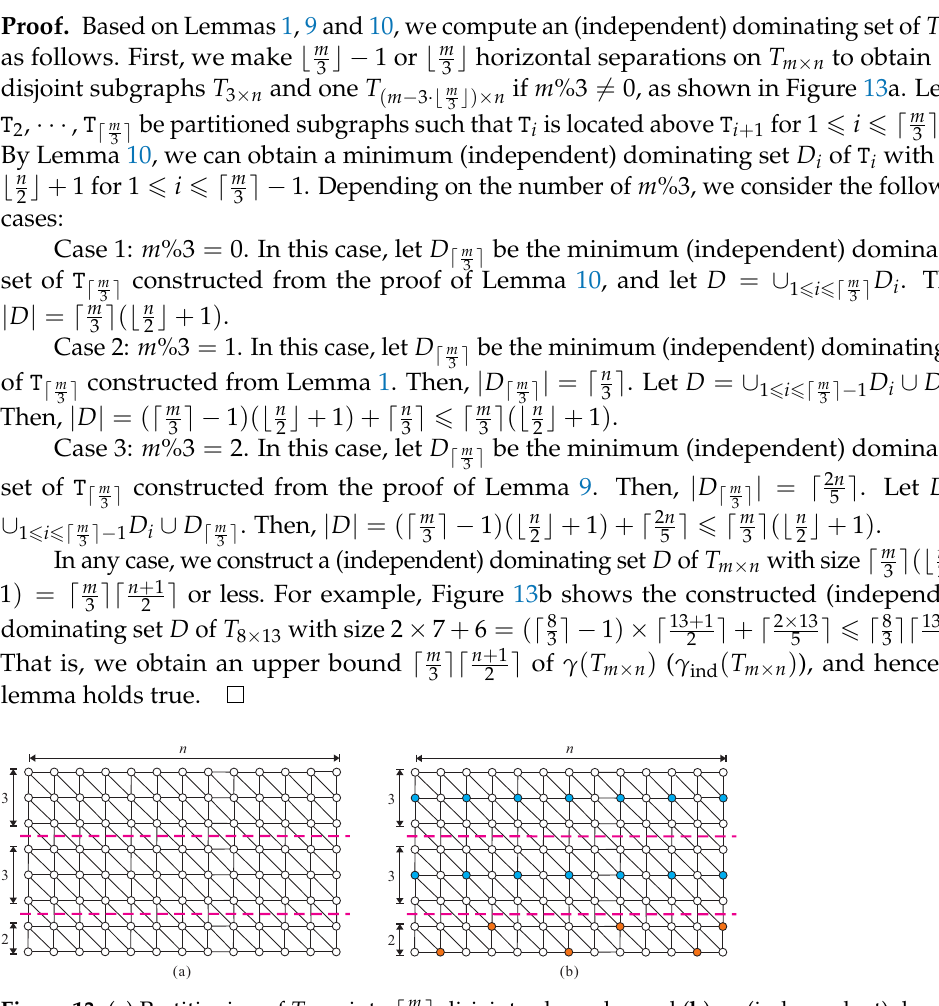
Figure 12. γ ( T 3 × n ) = γ ind ( T 3 × n ) = (cid:98) n minimum (independent) dominating set of T 3 × n .